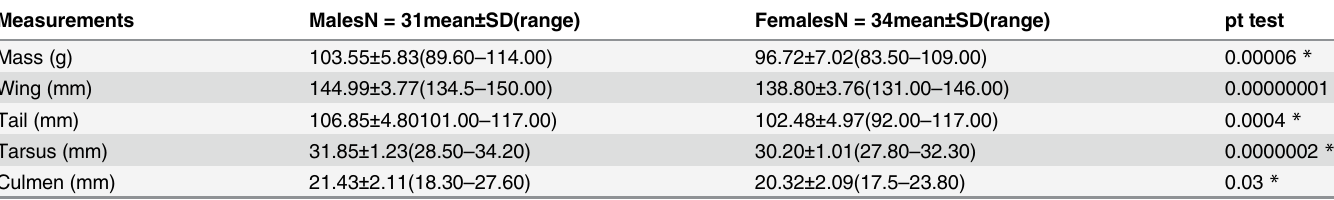
Table 1. Morphological characteristics for males and females.